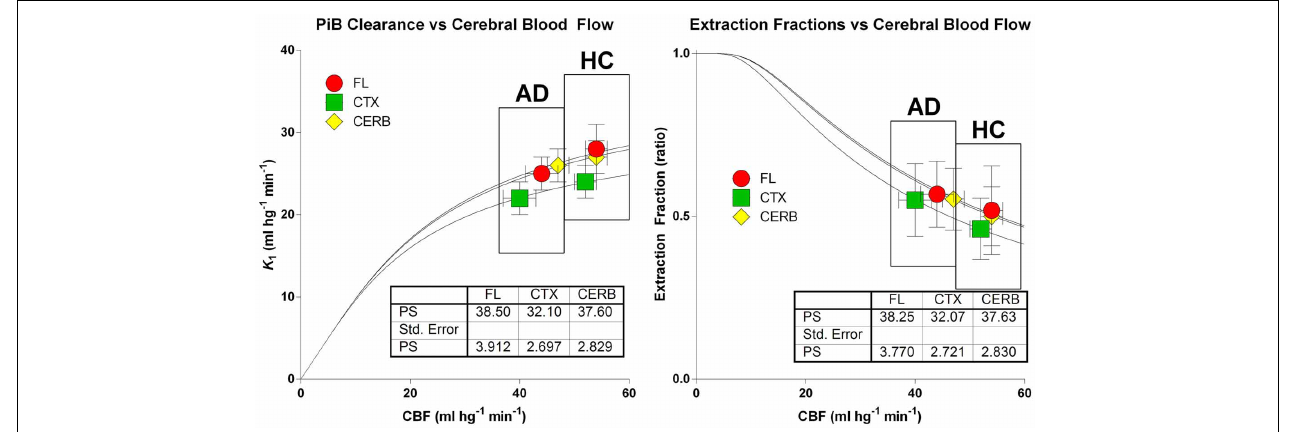
FIGURE 8 | Relations among clearance (left panel) and extraction fraction (right panel) estimates and measured cerebral blood flow values in patients and healthy control subjects according to equations (6) and (7). Abscissae: Cerebral Blood Flow estimates (ml hg − 1 min − 1 ).